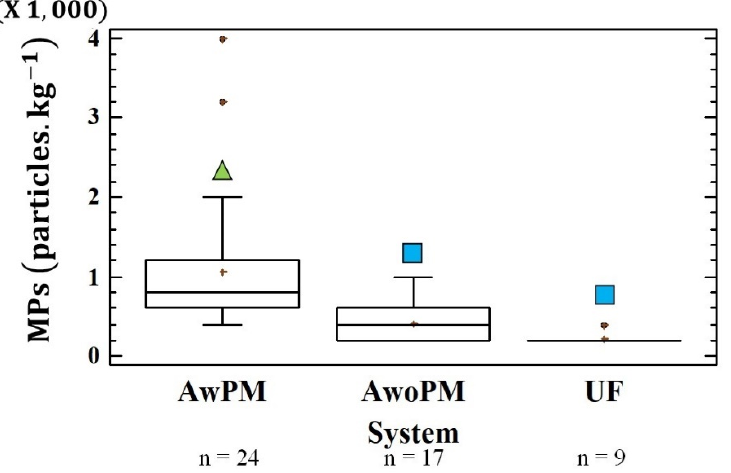
Figure 5. Microplastic counts (MPs) per system. Each small square indicates an outlier, + = mean, middle horizontal line indicates median, n = number of sampling points to statistical analysis. Different geometric figures implies significantly different groups (Mann–Whitney U test, p < 0.05).